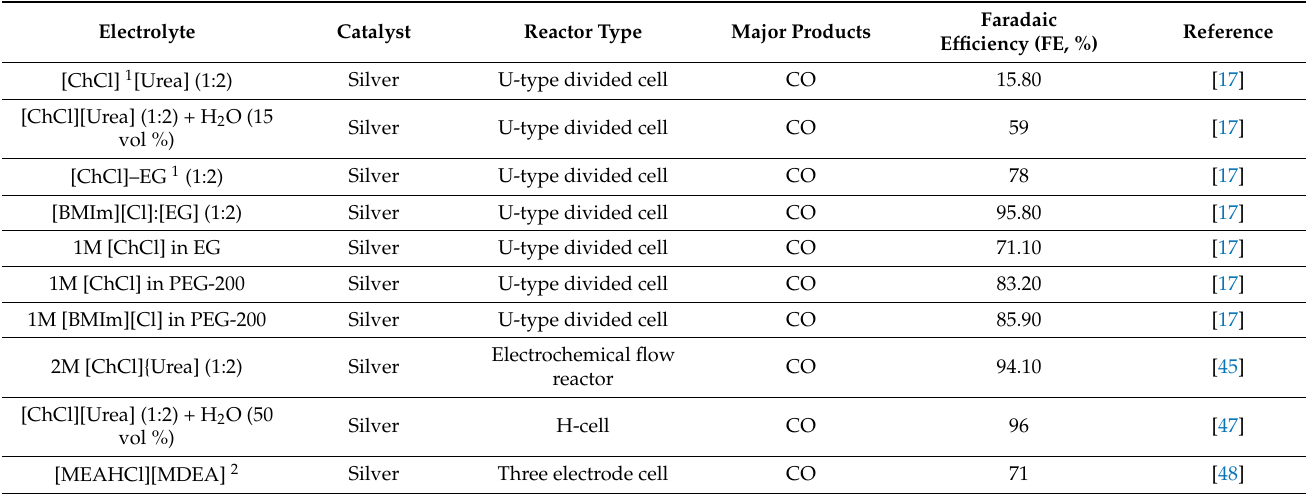
Table 3. Summary of DESs used in the electroreduction of CO 2